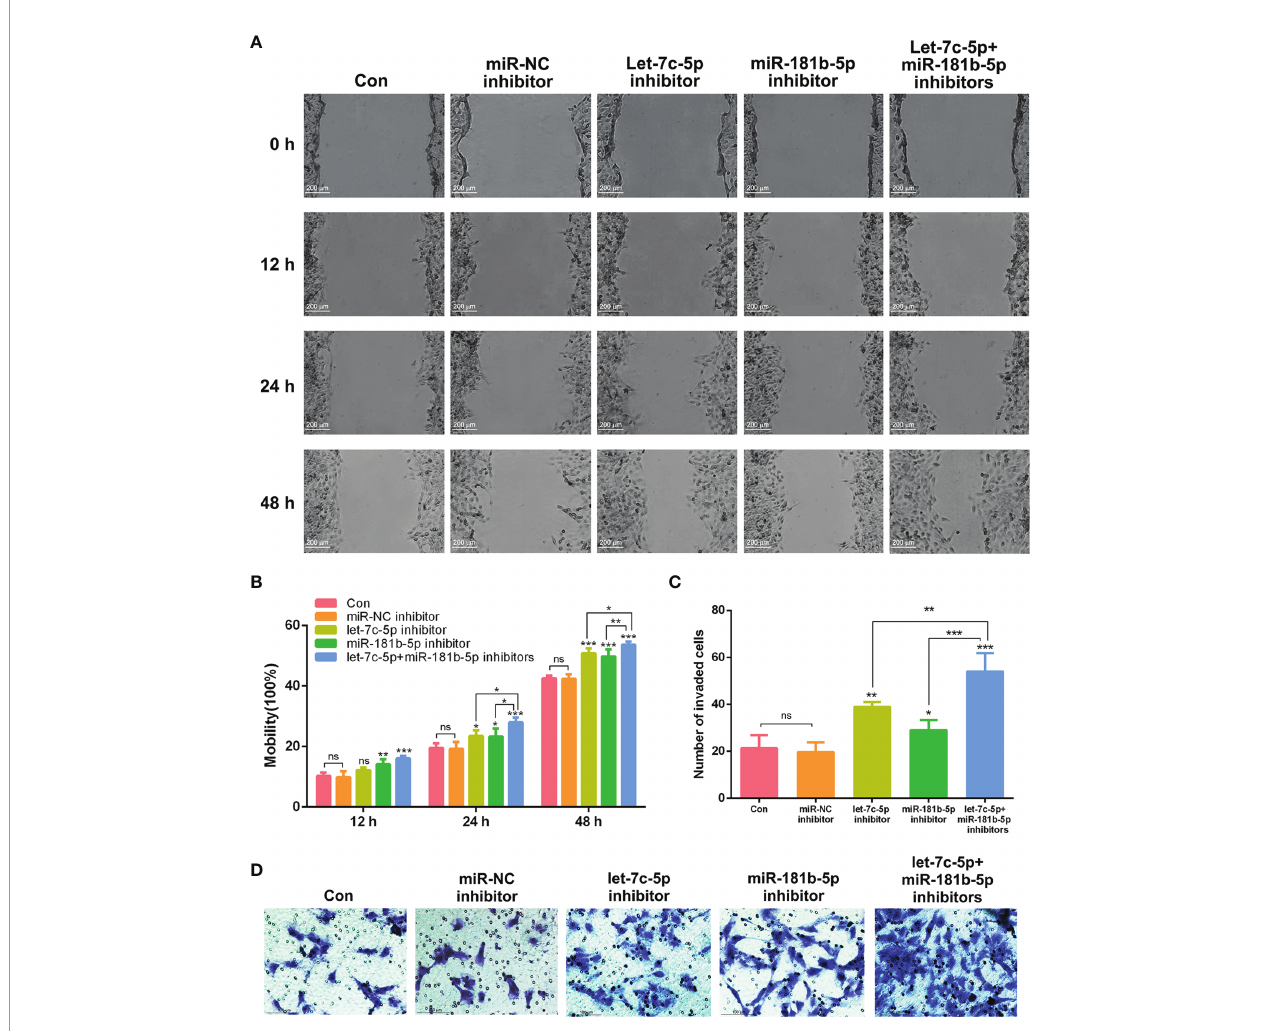
FIGURE 5 | let-7c-5p and miR-181b-5p inhibitors induced the migration and invasion of BEAS-2B cells. (A) Wound healing assay was used to identify the migration of BEAS-2B cells that were in fl uenced by let-7c-5p and miR-181b-5p inhibitors for 0, 12, 24, and 48 h. Statistical analysis of (B) mobility and (C) invasion ratio of BEAS-2B cells treated with let-7c-5p and miR-181b-5p inhibitors. ns represents no signi fi cance; * p <0.05, ** p <0.01, and *** p <0.001, and n ≥ 3. (D) Transwell assay was used to identify the invasion of BEAS-2B cells that were in fl uenced by let-7c-5p and miR-181b-5p